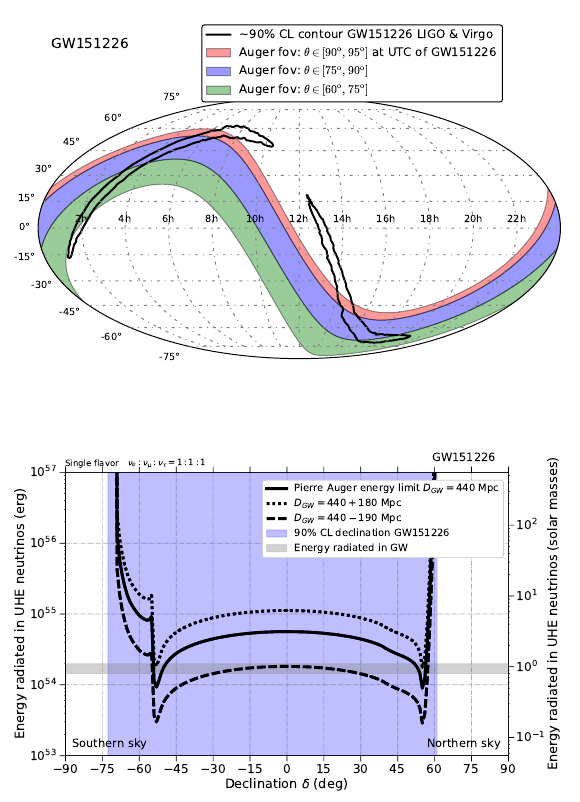
Figure 5. Top: Sky map of the field of view of the Pierre Auger Observatory in equatorial coordinates at the instant of detection of the binary black hole merger event GW151226 by Advanced LIGO. The band limits from top to bottom correspond to lines of zenith angles 95 ◦ , 90 ◦ , 75 ◦ and 60 ◦ . The black contours give the 90% C.L. region of the localization of the BBH merger. Bottom: Upper limit at 90% C.L. to the total energy in UHE neutrinos in the 10 17 to 2 . 5 × 10 19 eV range as a function of declination. The blue shaded band is the 90% C.L. of the reconstructed source declination, and the gray band the energy radiated in the form of GW accounting for uncertainties in distance to the source